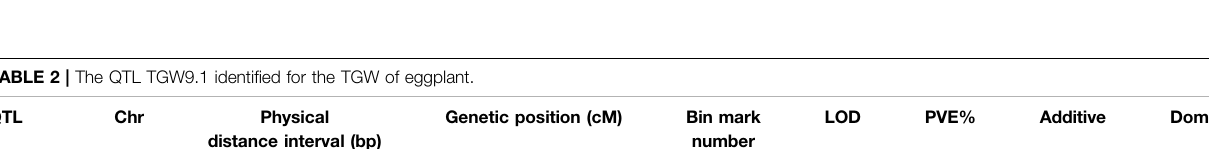
FIGURE 2 | Quantitative trait locus (QTL) regions associated with the TGW. The markers within QTL regions associated were highlighted with red.